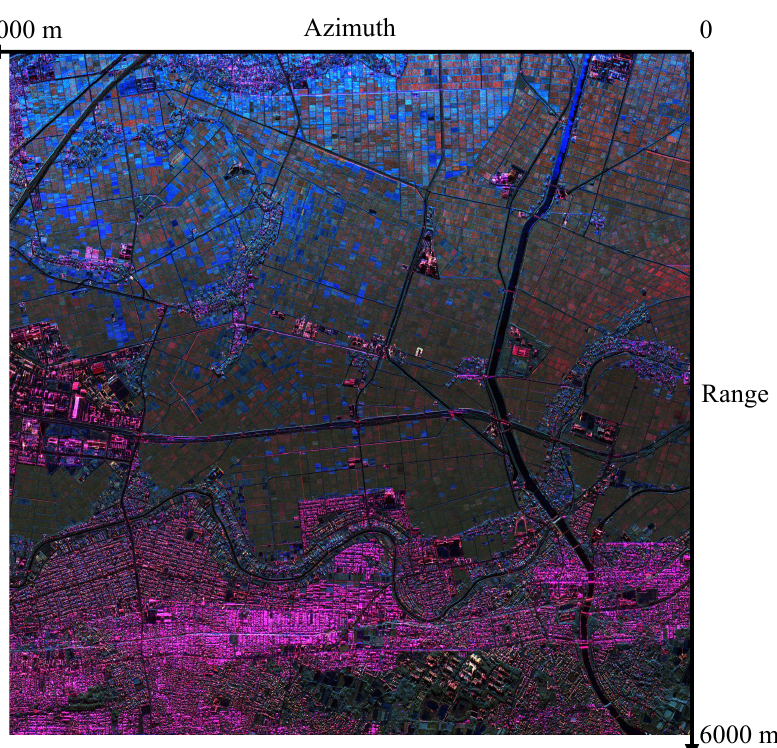
Figure 15. Another 6SD image before calibration near Niigata Univ. on 25 August 2013 (Center: N37.852, E138.965).